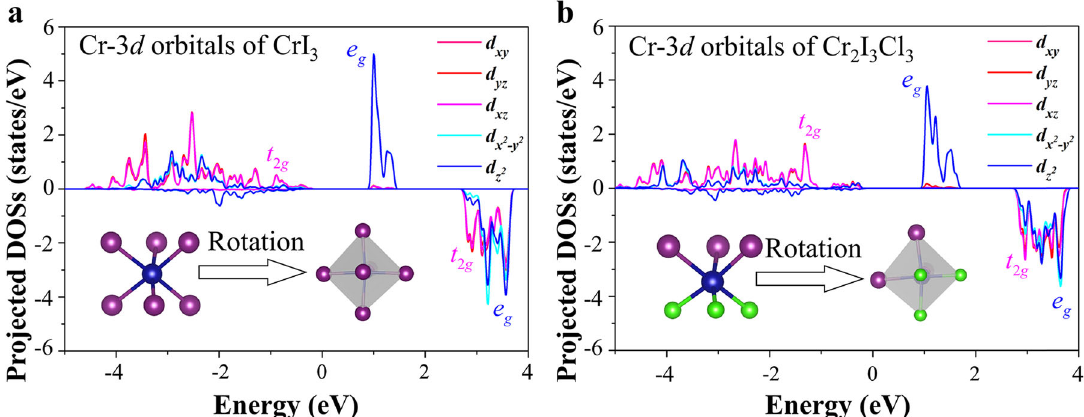
Fig. 3 Projected DOSs of Cr-3 d orbitals by coordination matching. a , b Projected DOSs of Cr-3 d orbitals of ( a ) Cr 2 I 6 and ( b ) Cr 2 I 3 Cl 3 without SOC after changing d orbitals from trigonal prismatic fi eld to octahedral crystal fi eld by coordination matching. The insets are schematic of rotation of Cr centered octahedron. Amethyst, blue, and green balls present I, Cr, and Cl atoms,